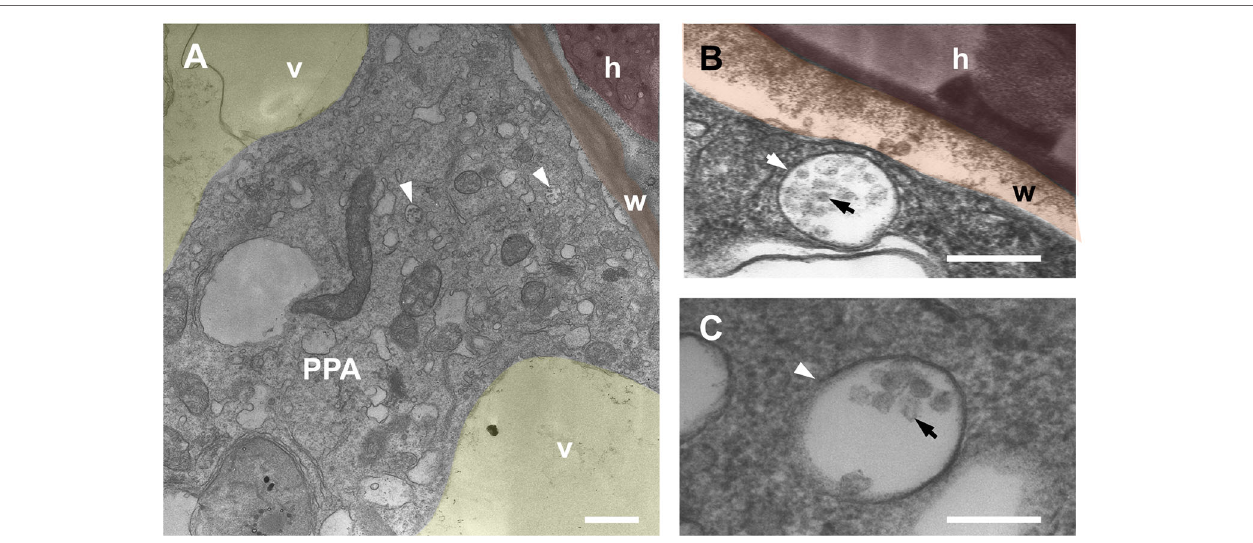
FIGURE 3 | TEM imaging of multivesicular bodies within Daucus carota PPA aggregates. Panel (A) shows a PPA inside a cortical cell of D. carota . The cytoplasmic aggregation splitting the vacuole (v, yellow) is assembled in front of an intraradical hypha (h, red) that is contacting the cell wall (w, orange). Several multivesicular bodies (MVBs) are visible (arrows). High magni fi cation close-ups of single MVBs are presented in panels (B and C) , highlighting the characteristic presence of an outer endosomal membrane (white arrow) and several intraluminal vesicles (black arrow). Bars = 0.8 µm in A, 0.2 µm in B, 0.1 µm in C; false colors were overlaid to the original TEM images for